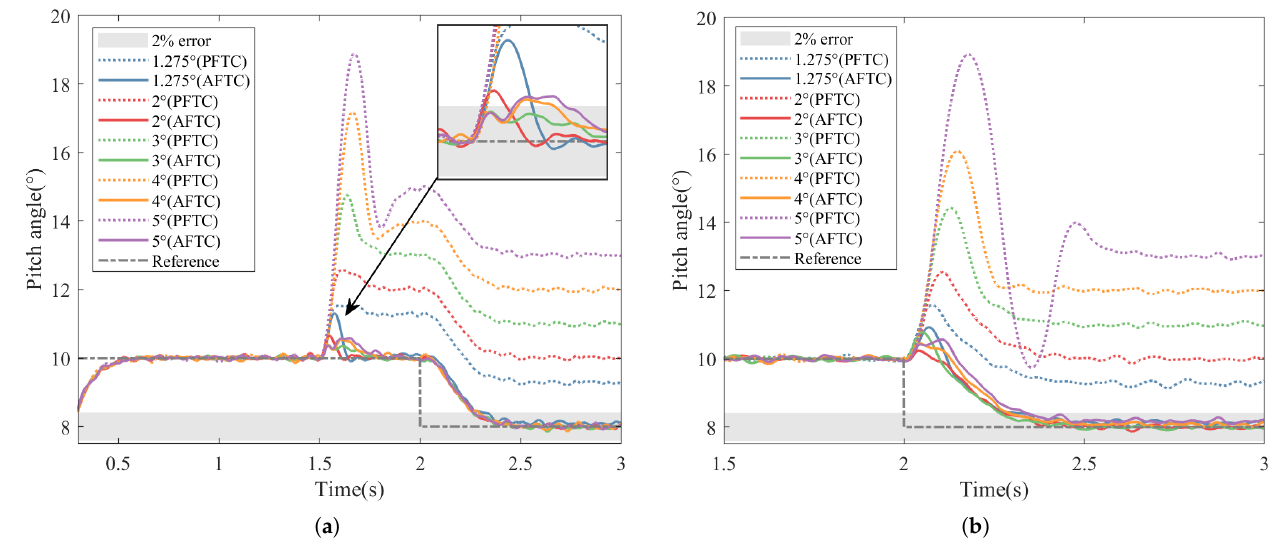
Figure 10. Comparative results of the proposed ADRC-based active fault-tolerant control for QUAV with the hard-over fault occurred at ( a ) 1.5 s. ( b ) 2 s.